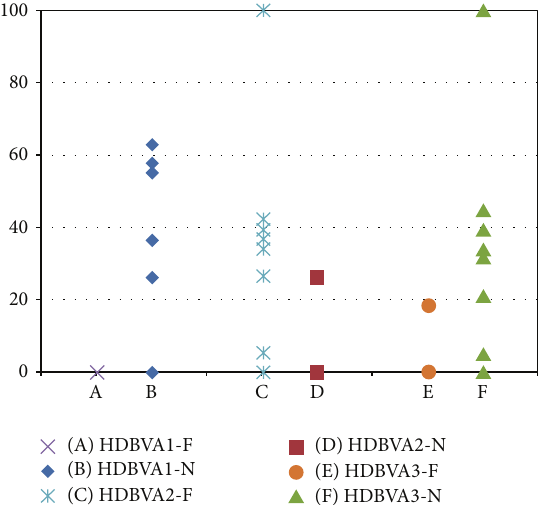
Figure 17: In-Range slider displacement percentages of case Figure 10(d).